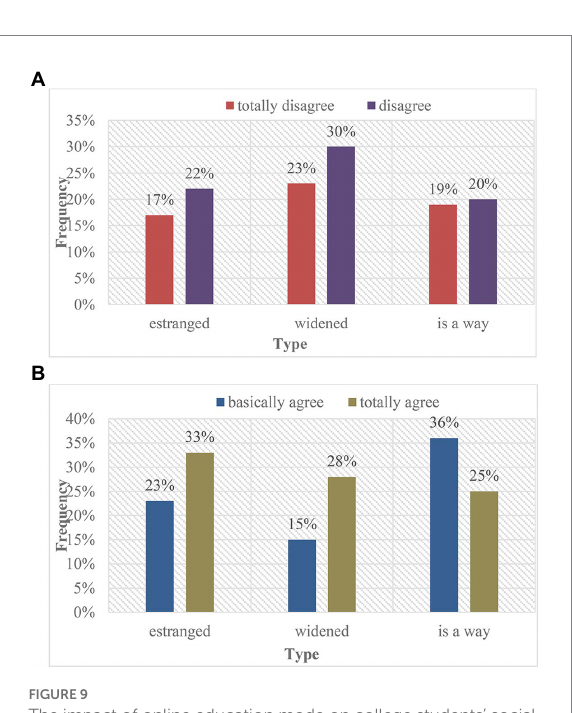
The long-term online education model during the epidemic has given many college students no opportunity to expand their circle of friends, and some even closed themselves (Choi et al., 2021), as shown in Figure 9.